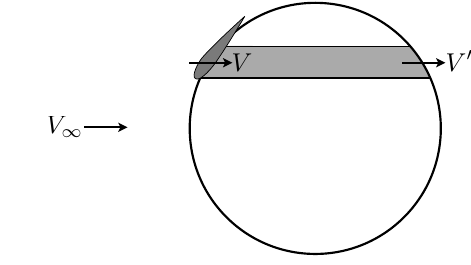
Figure 1. Double multiple streamtube concept with multiple streamtubes along the VAWT (one shown) and separate “actuator disks” on both the upstream and downstream surfaces.